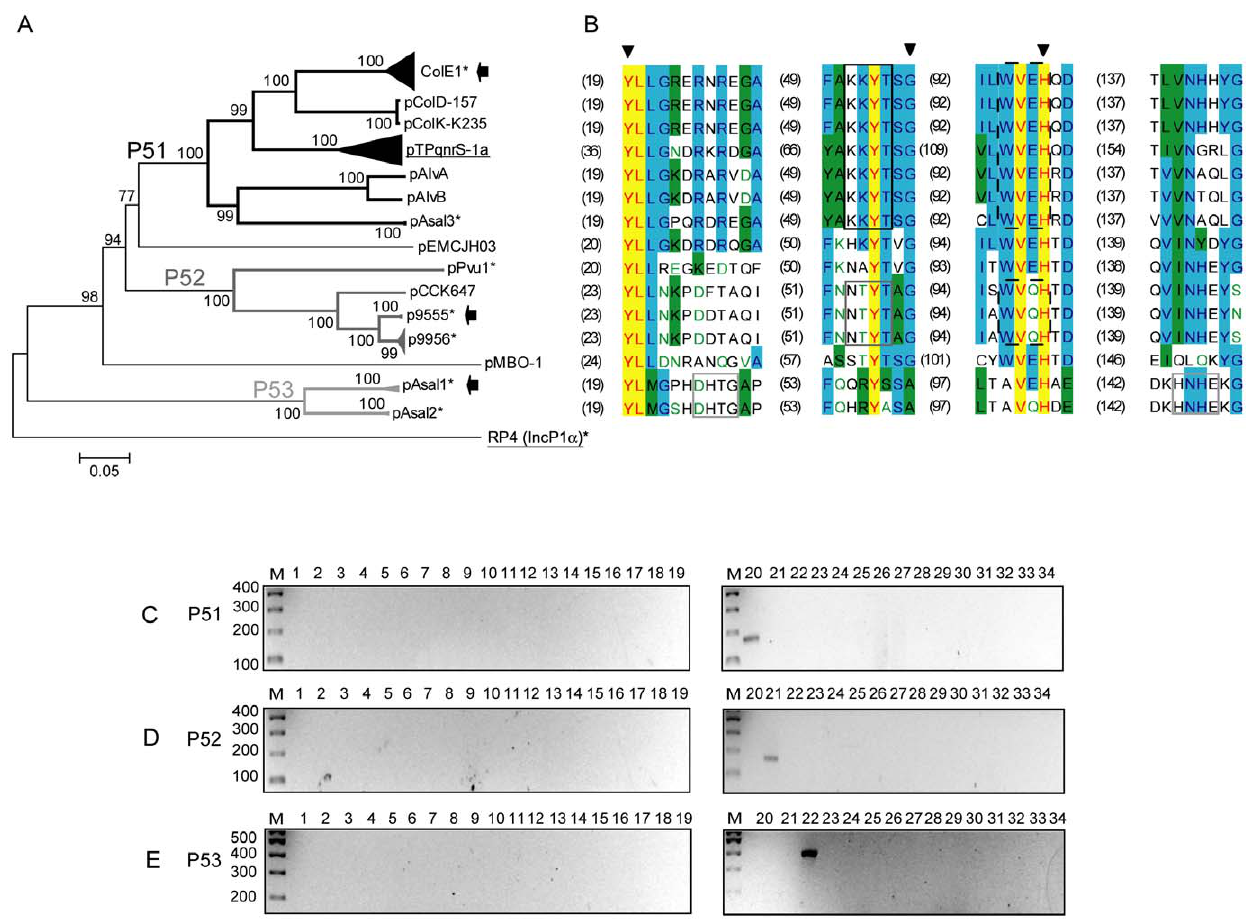
Figure 4. DPMT validation for MOB P5 relaxases. A) Phylogenetic tree of MOB P5 relaxase family. B) Alignment of the relaxase motifs used to design the MOB P5 degenerate primers (P51-f, continuous black; P52-f, continuous dark grey; P5-r, dashed black; and P53-f + P53-r, continuous grey) C) Amplicons obtained with primers for subfamily MOB P51 (P51-f and P5-r). D) Amplicons obtained with primers for subfamily MOB P52 (P52-f and P5-r). E) Amplicons obtained with primers for subfamily MOB P53 (P53-f and P53-r). Symbols, colour codes and lanes as in Figure 1.